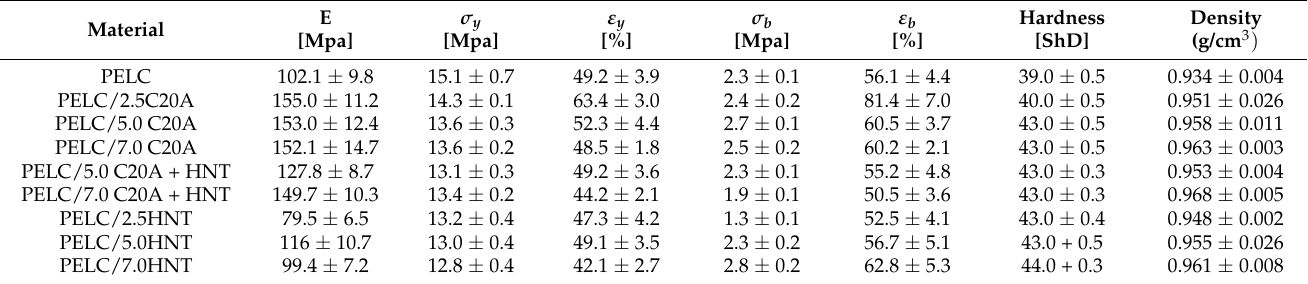
Table 4. Mechanical properties for PELC-based